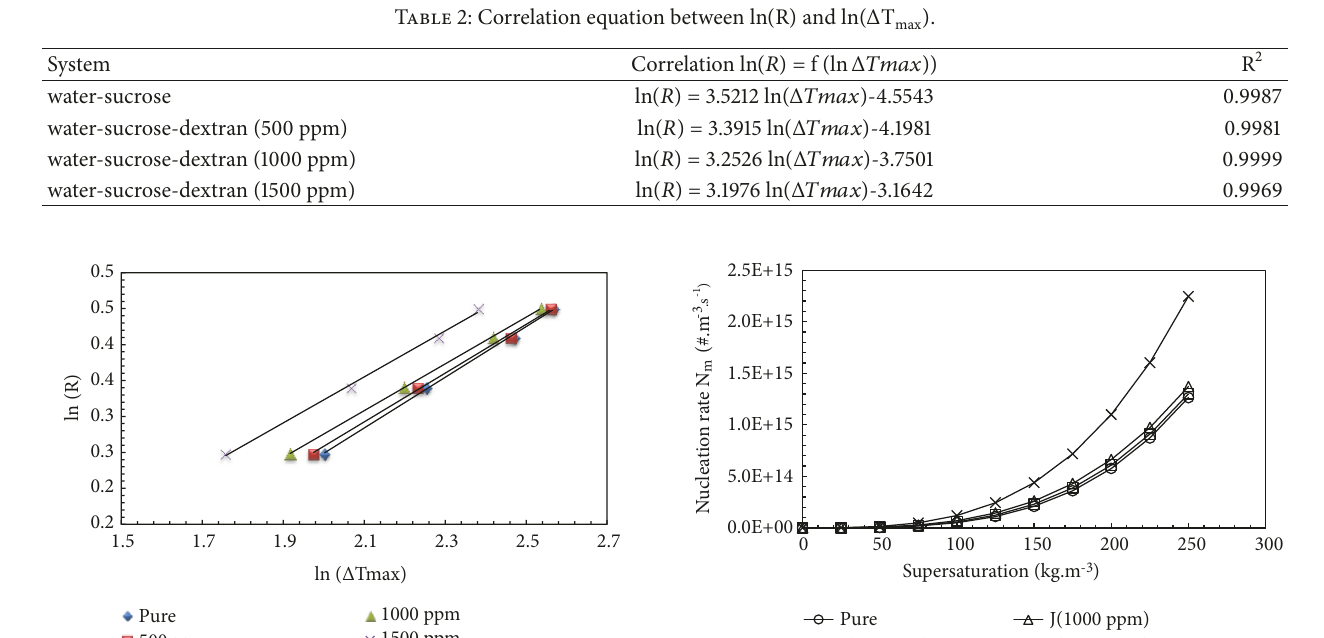
Table 2: Correlation equation between ln ( R ) and ln (Δ T